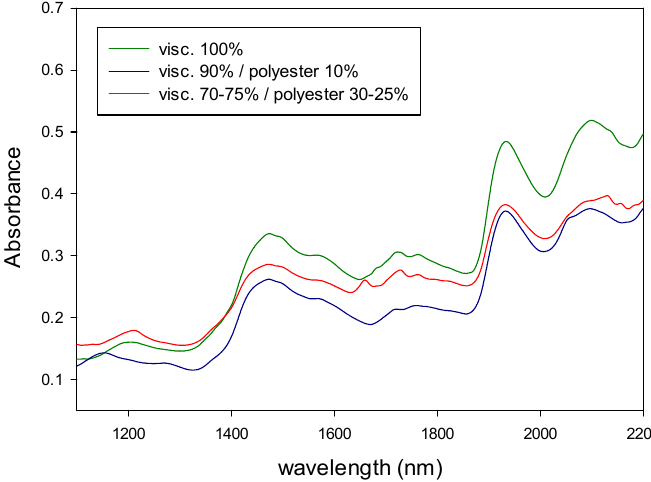
Figure 6. NIR spectra of binary mixtures of viscose/polyester.